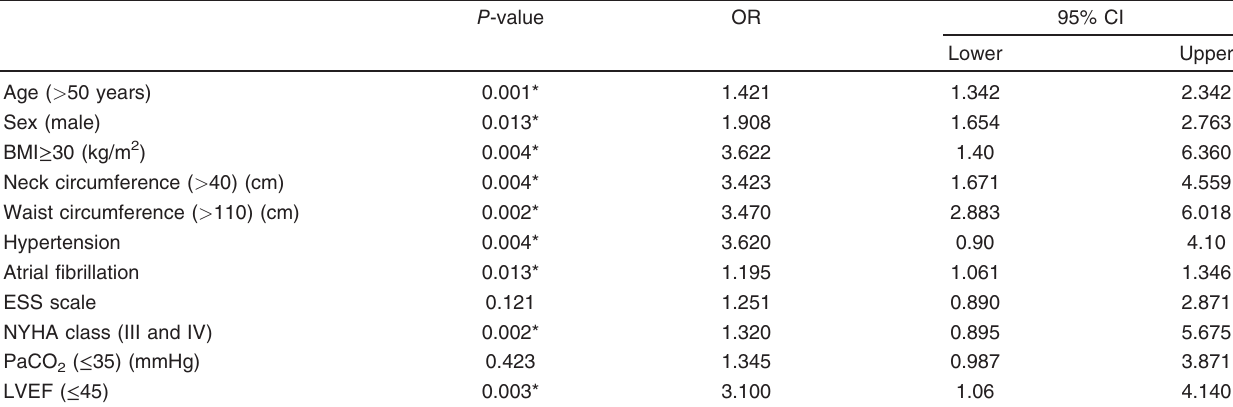
Table 7 Logistic regression analysis revealing the possible predictors for sleep-disordered breathing in patients with heart